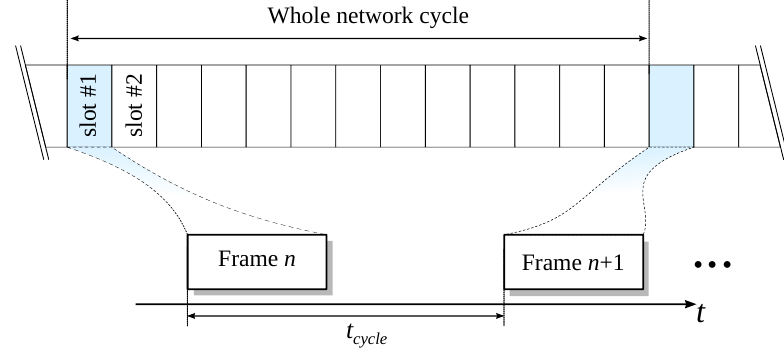
Figure 3. The generated traffic